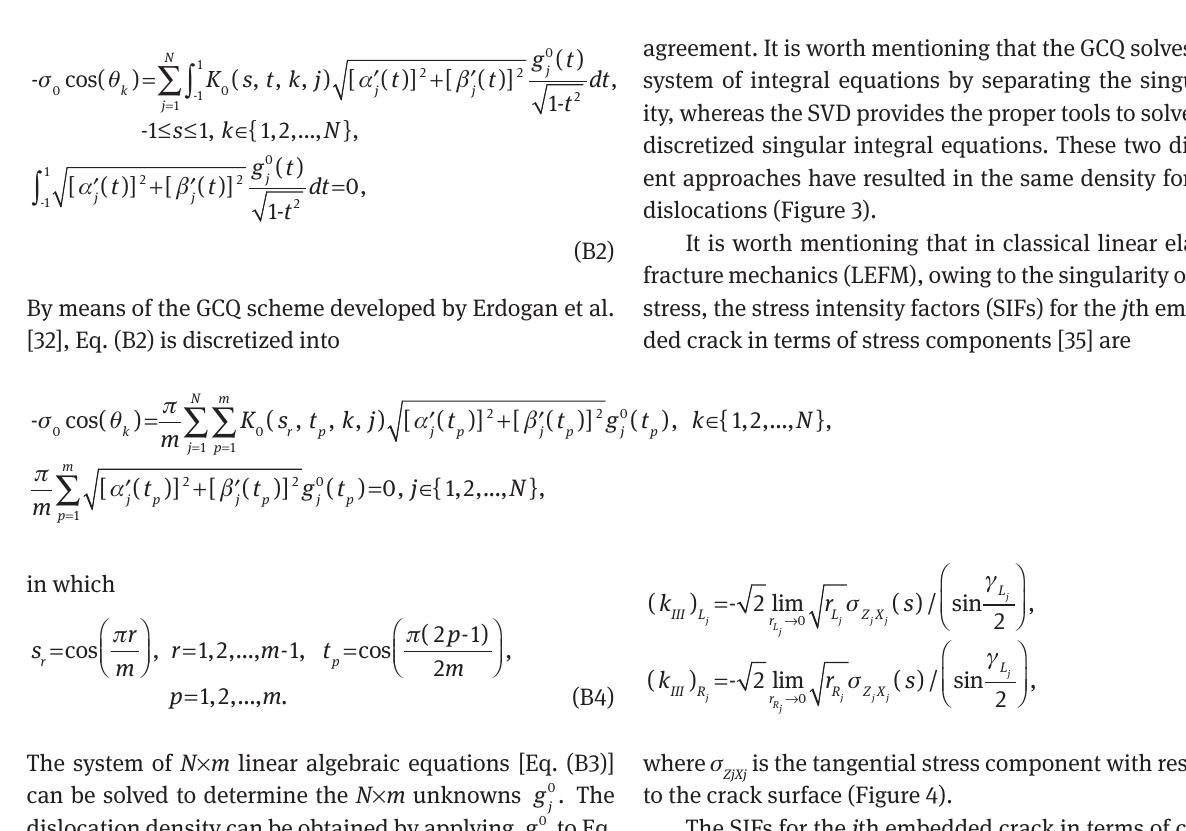
Figure 3 Classical dislocation densities obtained from SVD and GCQ for a horizontal crack in a graded plane ( γ a = 0.2 , l = 0.01 a , l ′ = l